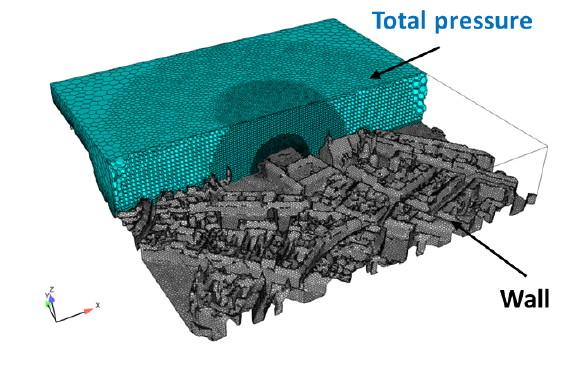
Figure 2. Polyhedral mesh based on the imported 3D model.